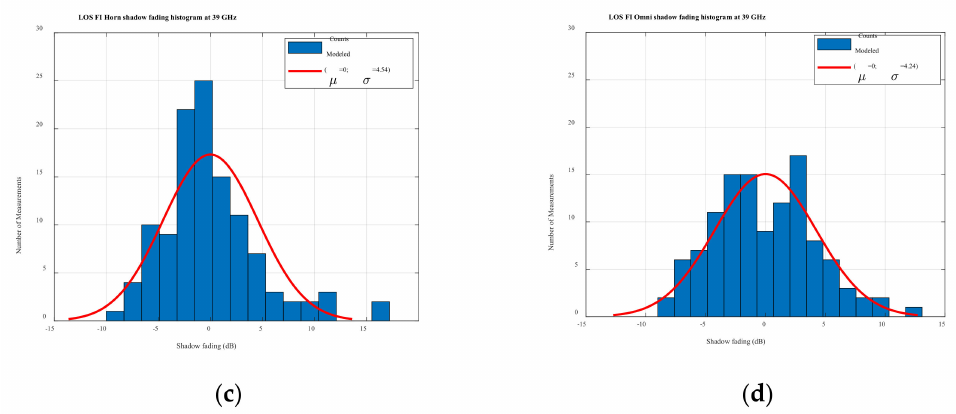
Figure 8. LOS shadow fading histogram at 39 GHz for the ( a ) CI Horn, ( b ) CI Omni, ( c ) FI Horn, and ( d ) FI Omni cases.